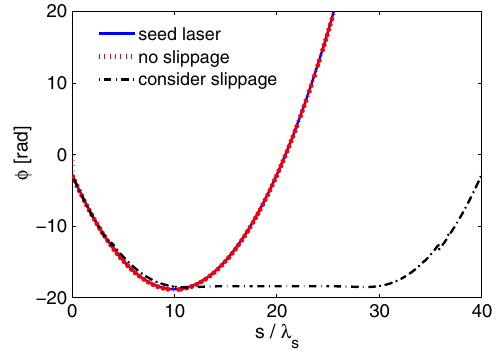
FIG. 2. Spectral phase distributions of the seed laser and energy modulations: quadratic phase in the seed laser (blue line) results in quadratic phase in the energy modulation when the slippage effect is neglected using Eq. (6) (red dots); when slippage effect is considered using Eq. (7) (black dash-dotted line), the phase distribution of the energy modulation is nearly flat in the central